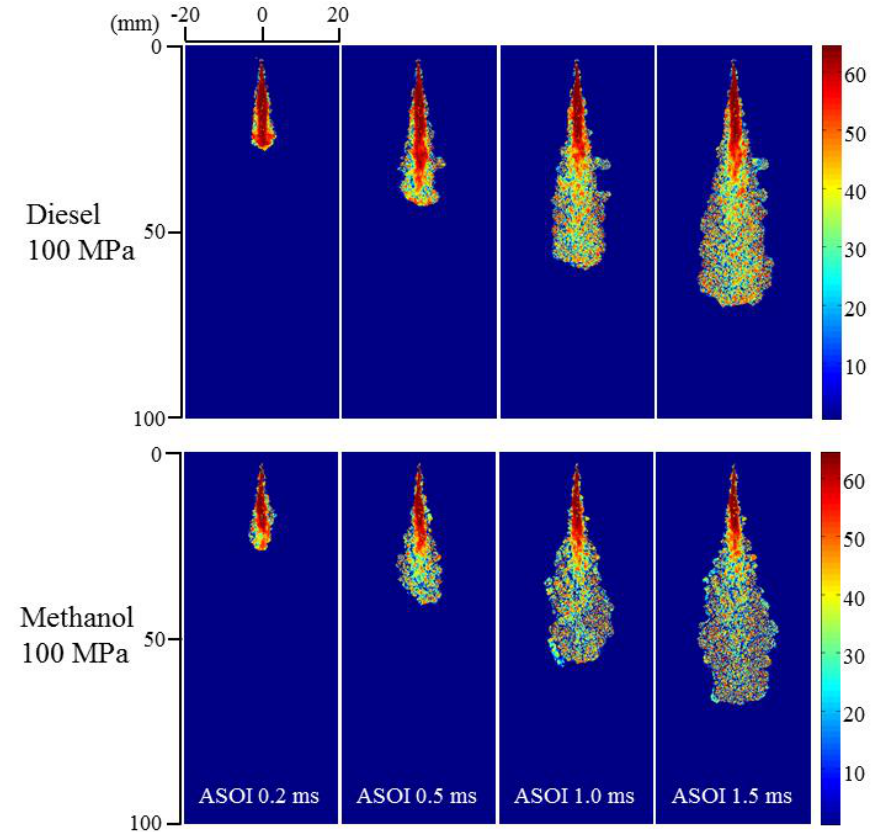
Figure 4. Comparison results of typical methanol and diesel evaporating sprays.